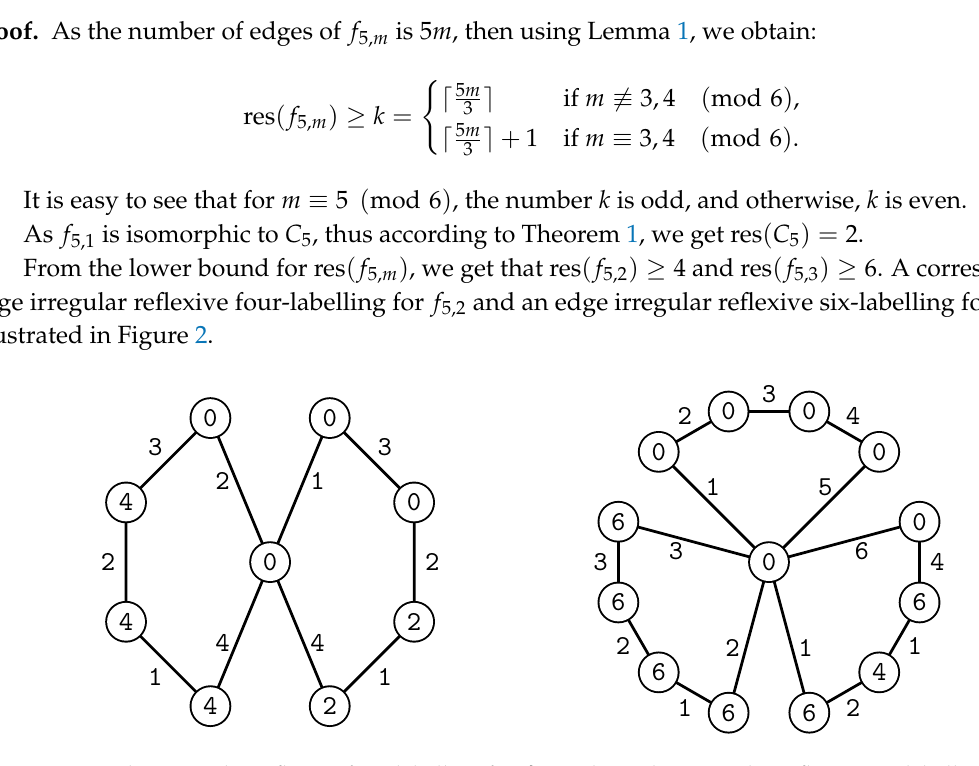
Figure 2. An edge irregular reflexive four-labelling for f 5,2 and an edge irregular reflexive six-labelling for f 5,3